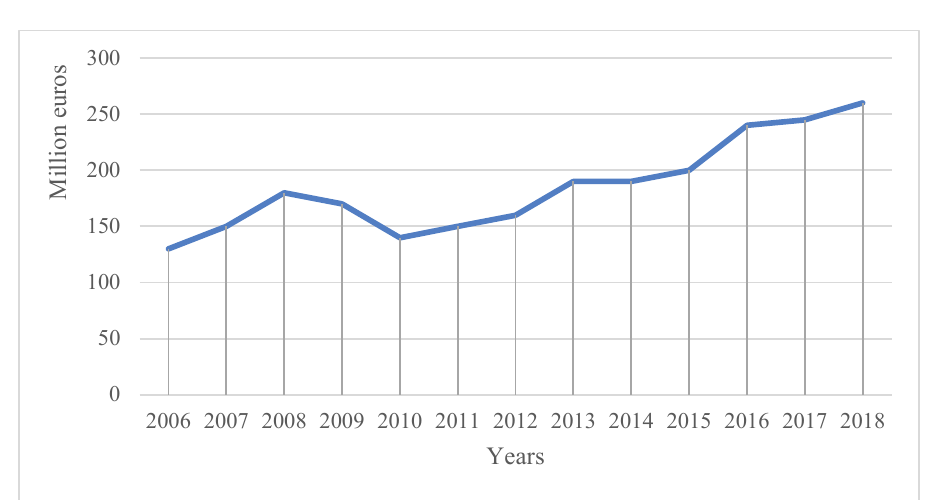
Fig. 2. Direct taxes (Budget of the Republic of Kosovo, Ministry of Finance in million euros (MoF). Annual Financial Report of 2006–2018).